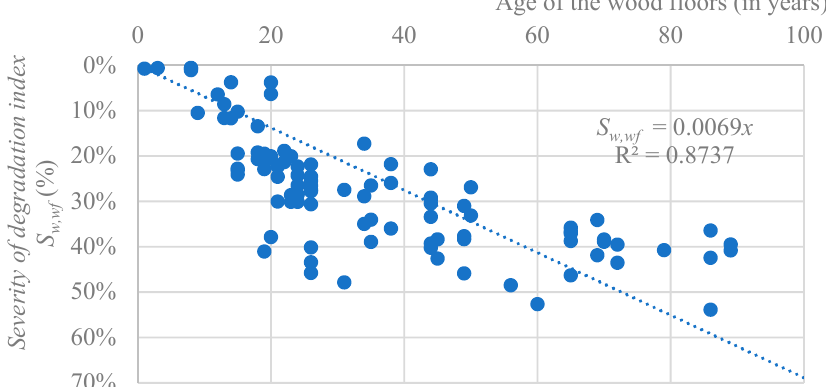
Figure 2. Regression analysis between the numerical index that expresses the degradation of the 96 wood flooring systems ( S w,wf ) and their age.